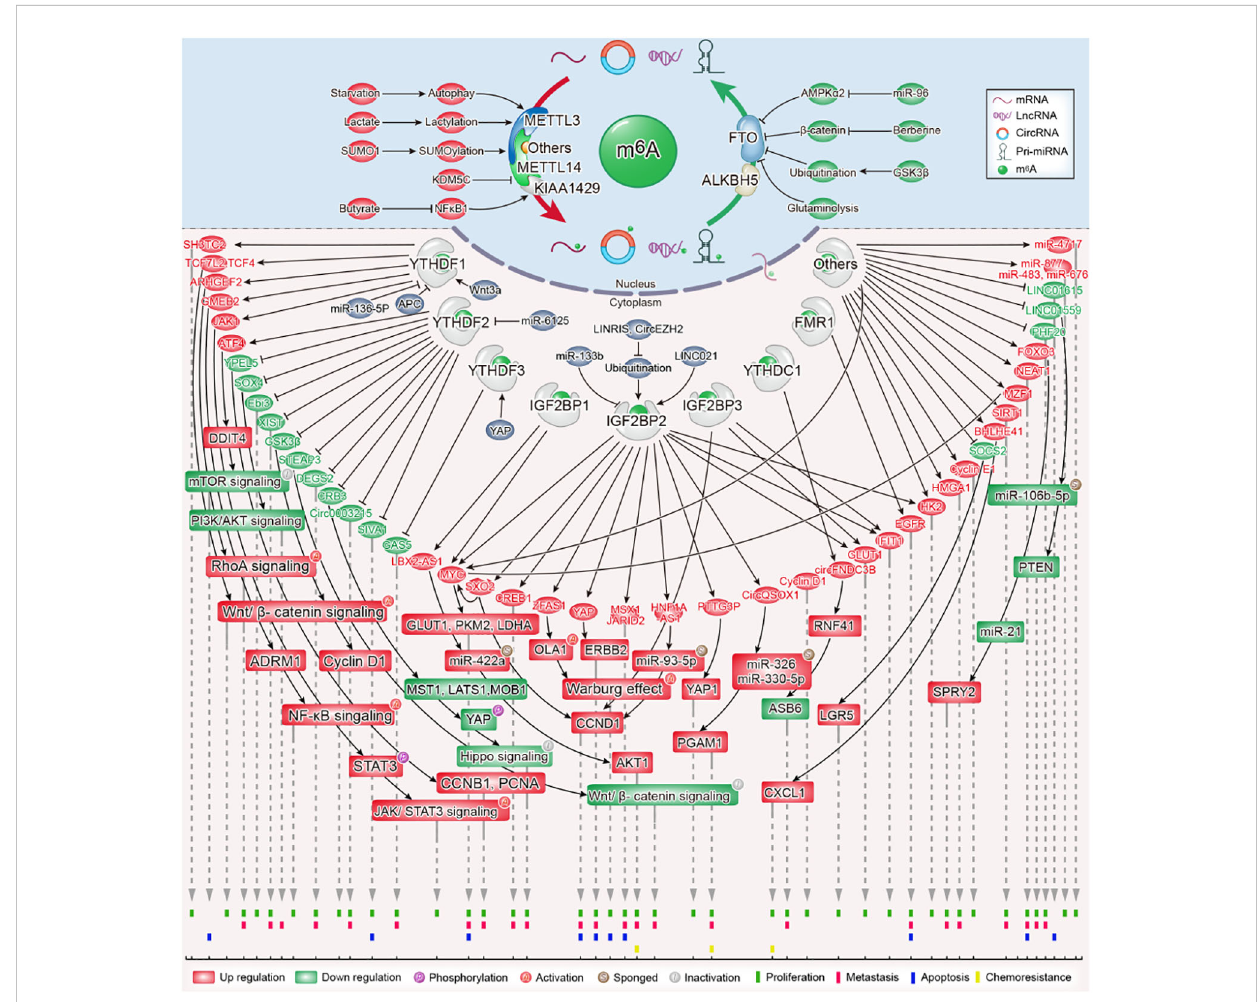
FIGURE 1 The role and molecular mechanism of m6A modi fi cation in colorectal